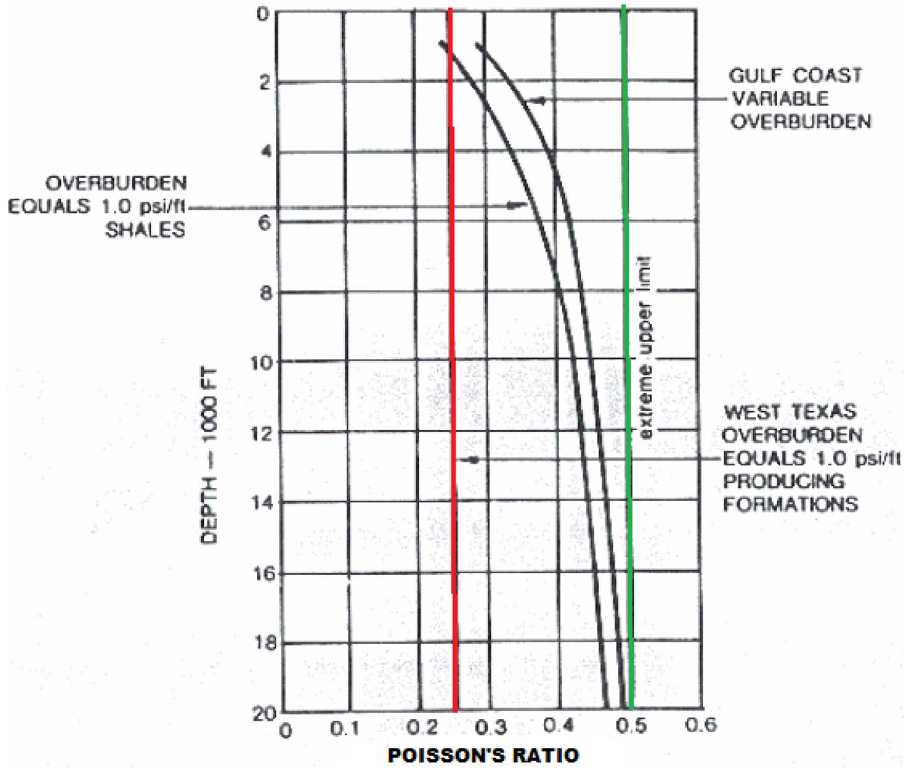
Fig. 4 Eaton’s Poisson’s ratio curve for Gulf of Mexico